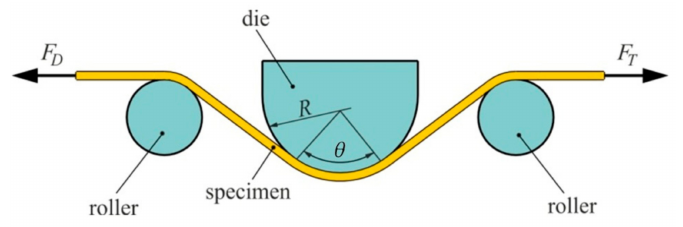
Figure 28. Schematic illustration of the flat-die strip drawing.